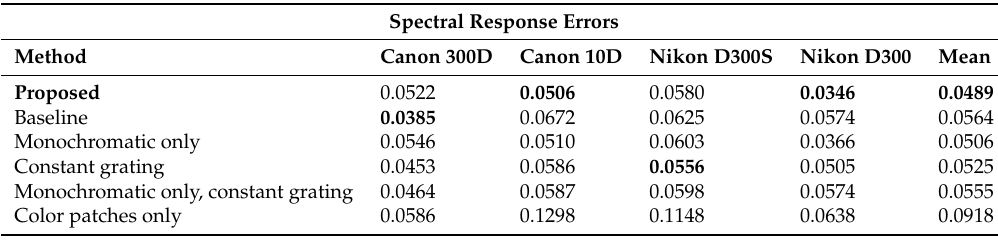
Table 2. Mean absolute error of spectral response compared to ground truth. Errors have been calculated between the range 400–700 nm as ground truth data is only available for this range. Of all the compared methods, the proposed method produces the lowest mean error. Bolded values indicate lowest error for each